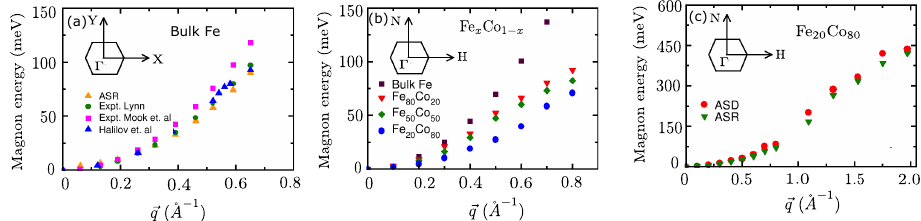
Figure 2. ( a ) Magnon dispersion spectrum for bulk bcc Fe along the Γ − Y direction from ASR. For comparison, the experimental spin-wave spectrum of bulk bcc Fe by Lynn (Ref. [71]) and data from another experimental study corresponding to a spin-wave stiffness constant of D = 280 Å 2 by Mook et al. (Ref. [72]) are displayed. The blue triangles represent theoretical data by Halilov et al. (Ref. [73]). All comparisons were consistent with with the data from ASR [72]. ( b ) Magnon dispersion spectrum for bulk bcc Fe x Co 1 − x alloys along the high symmetric Γ − H direction in the Brillouin zone for three different Co concentrations from ASR. This shows magnon softening in the Fe 20 Co 80 alloy, compared with the others. ( c ) Magnon dispersion spectra for disordered Fe 20 Co 80 from ASR and ASD.